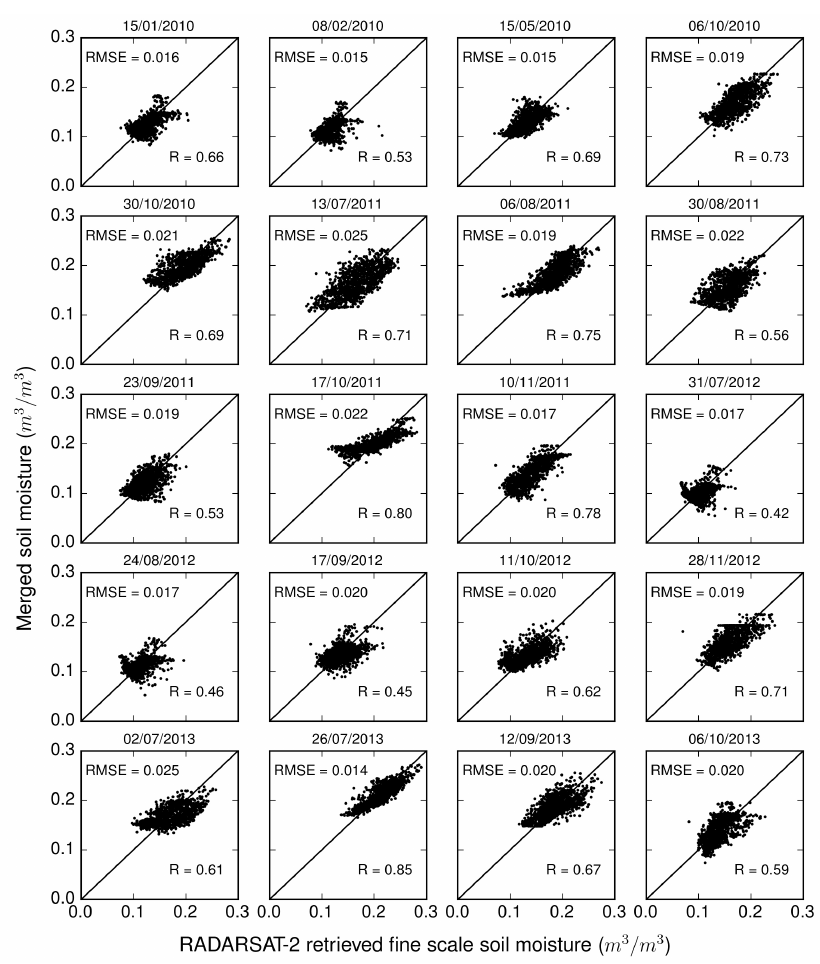
Figure 15. Comparison of the merged soil moisture with the RADARSAT-2 retrieved soil moisture at a spatial resolution of 500 m for the F-Cal experiment.